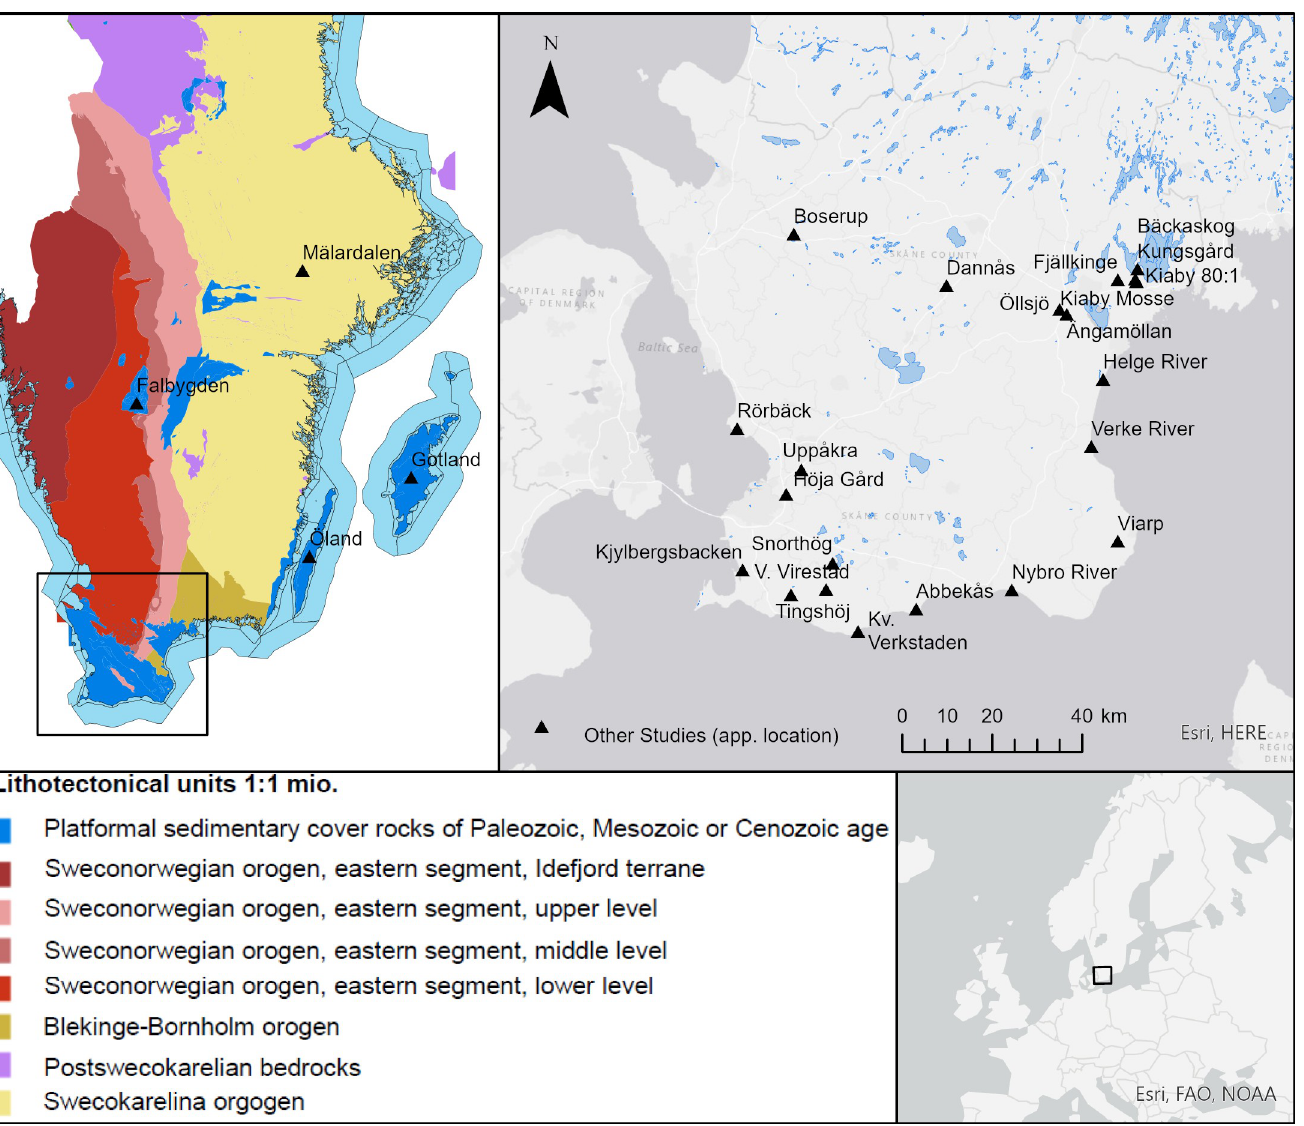
Fig 1. Scania, Southern Sweden. Upper left corner: Lithotectonical units of Scania and southern Sweden, based on the thematic, publically available 1:1 mio map from the Geological Survey of Sweden (www.Sgu.se). Approximate locations of sites from other studies mentioned in text [13,15,24–28]. Lower right corner showing study area on a European scale for orientation purposes. Maps generated using ESRI ArcGIS Pro software and basemaps, licensed to the National Museum of Denmark.